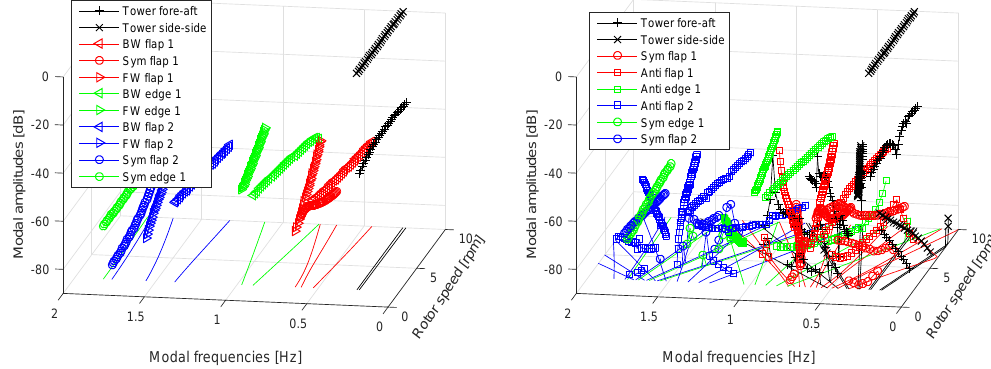
Figure 24. Periodic Campbell diagrams of all harmonic components of the tower side–side DOF in all investigated modes for the three- bladed (left panel) and two-bladed (right panel) version of the DTU 10MW